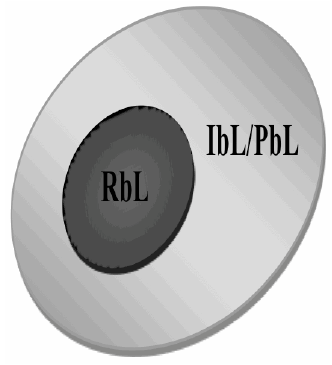
Figure 1. The relation between RbL and